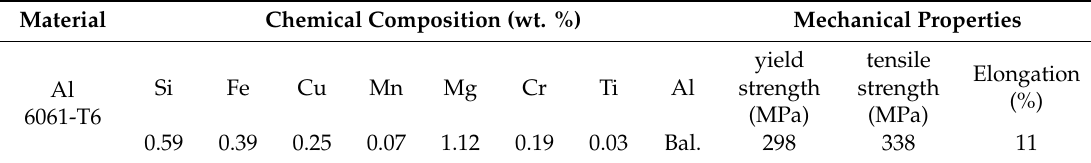
Table 1. Chemical composition and mechanical properties of aluminum alloy 6061-T6 used in this study.